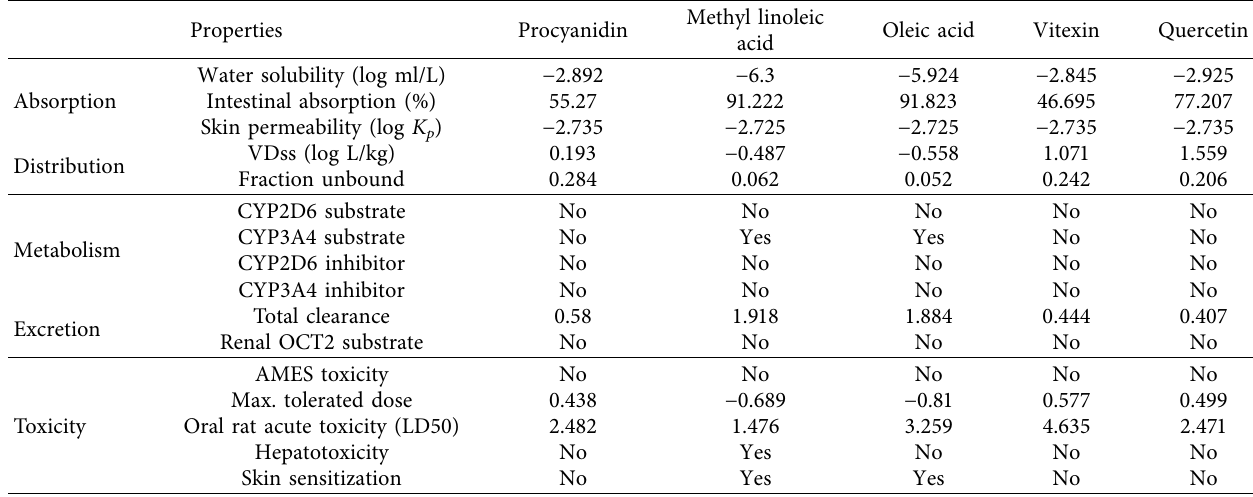
Table 4: Prediction results of ADMET properties of each